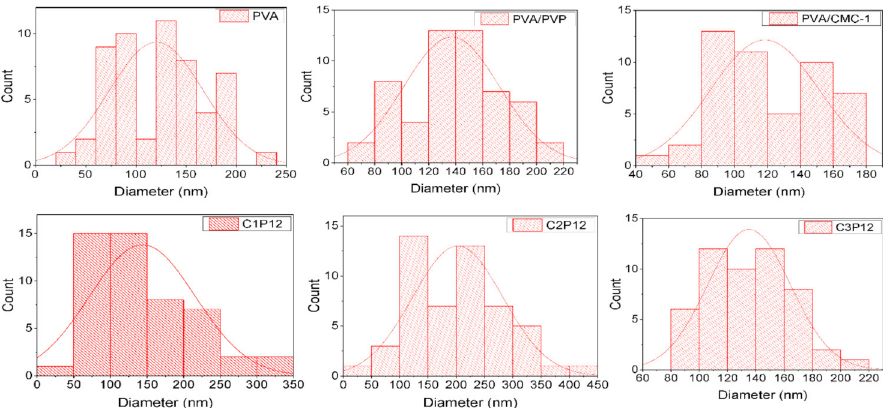
Figure 3. Diameter distribution of PVA, PVA/PVP, and tricomponent PVA/PVP/CMC nanofibers (the X-axis shows the diameter in nm, while the Y-axis shows the number of fibers in that diameter range).